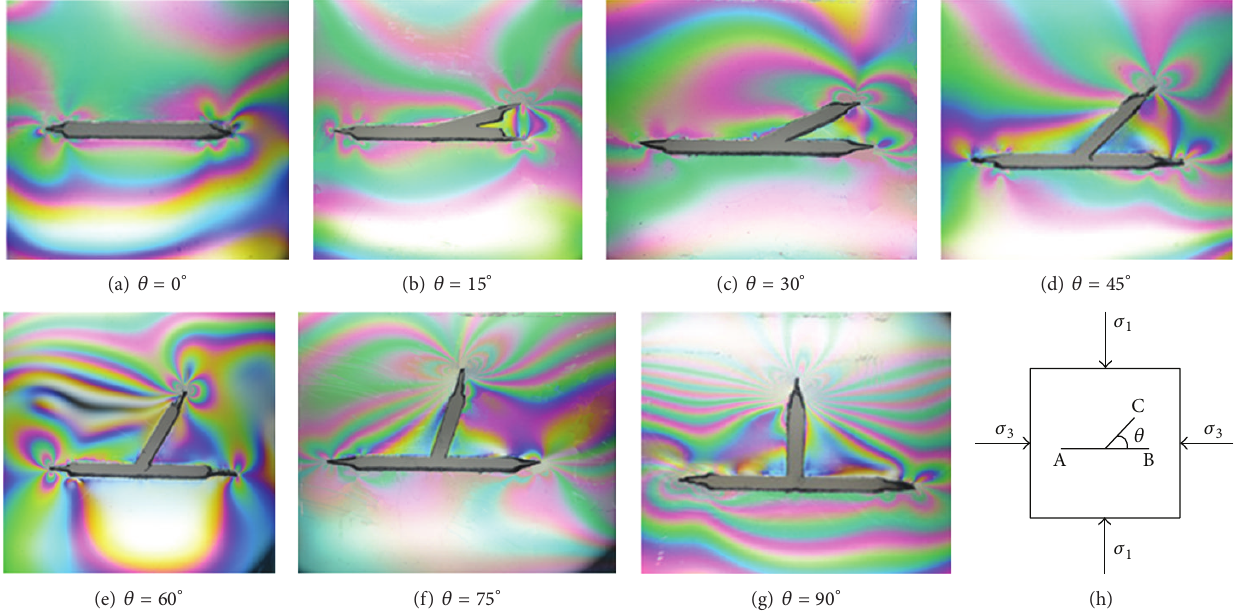
Figure 8: Isochromatic fringes of Y-shaped cracks under biaxial